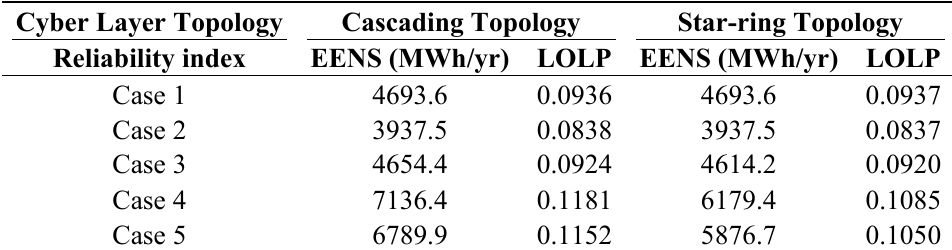
Table 7. The reliability indices of case